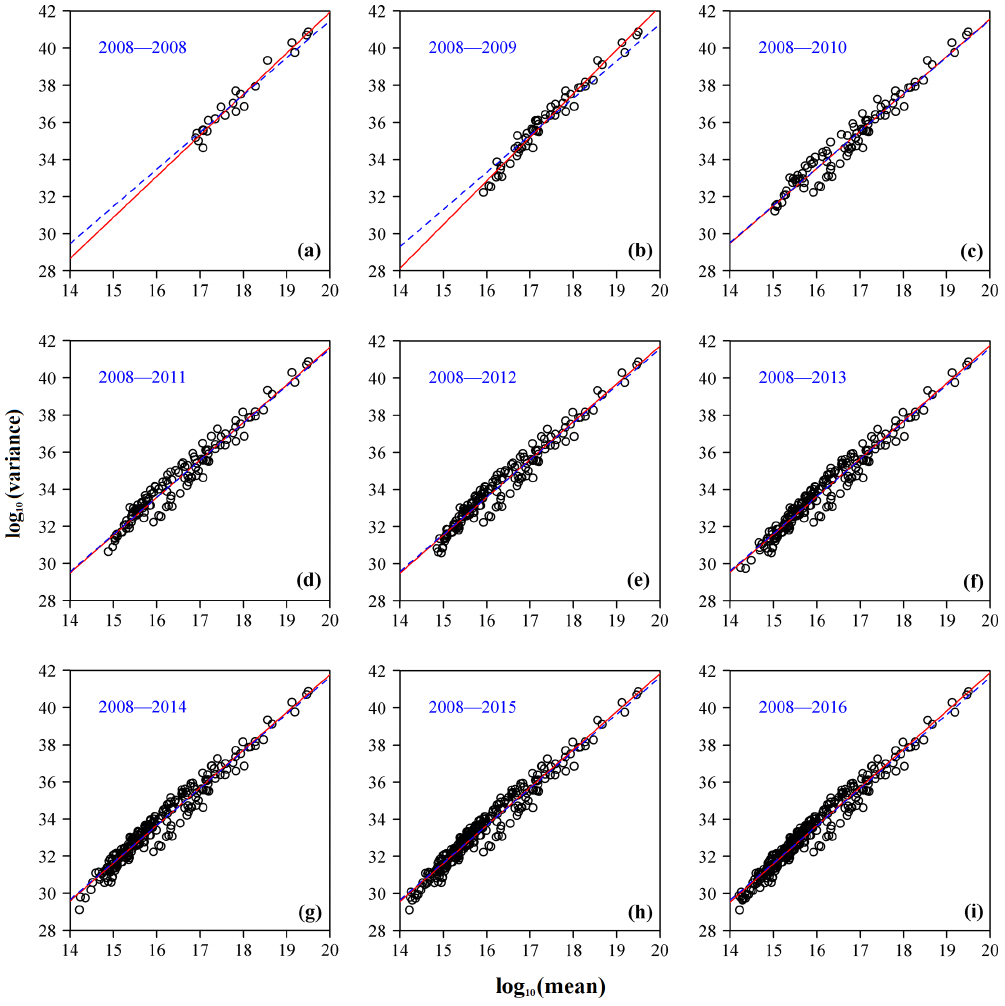
Figure 5. The calculated variance as a function of the observed mean of the energies from earthquakes in each block on a log–log scale (open circles) where A is fixed as 10. The red straight line corresponds to the fitted TPL with an unknown exponent, i.e. log 10 (σ 2 ) = c + b log 10 (µ) , using the least squares method. The blue dashed line corresponds to the fitted TPL with exponent 2, i.e. log 10 (σ 2 ) = d + 2log 10 (µ) .